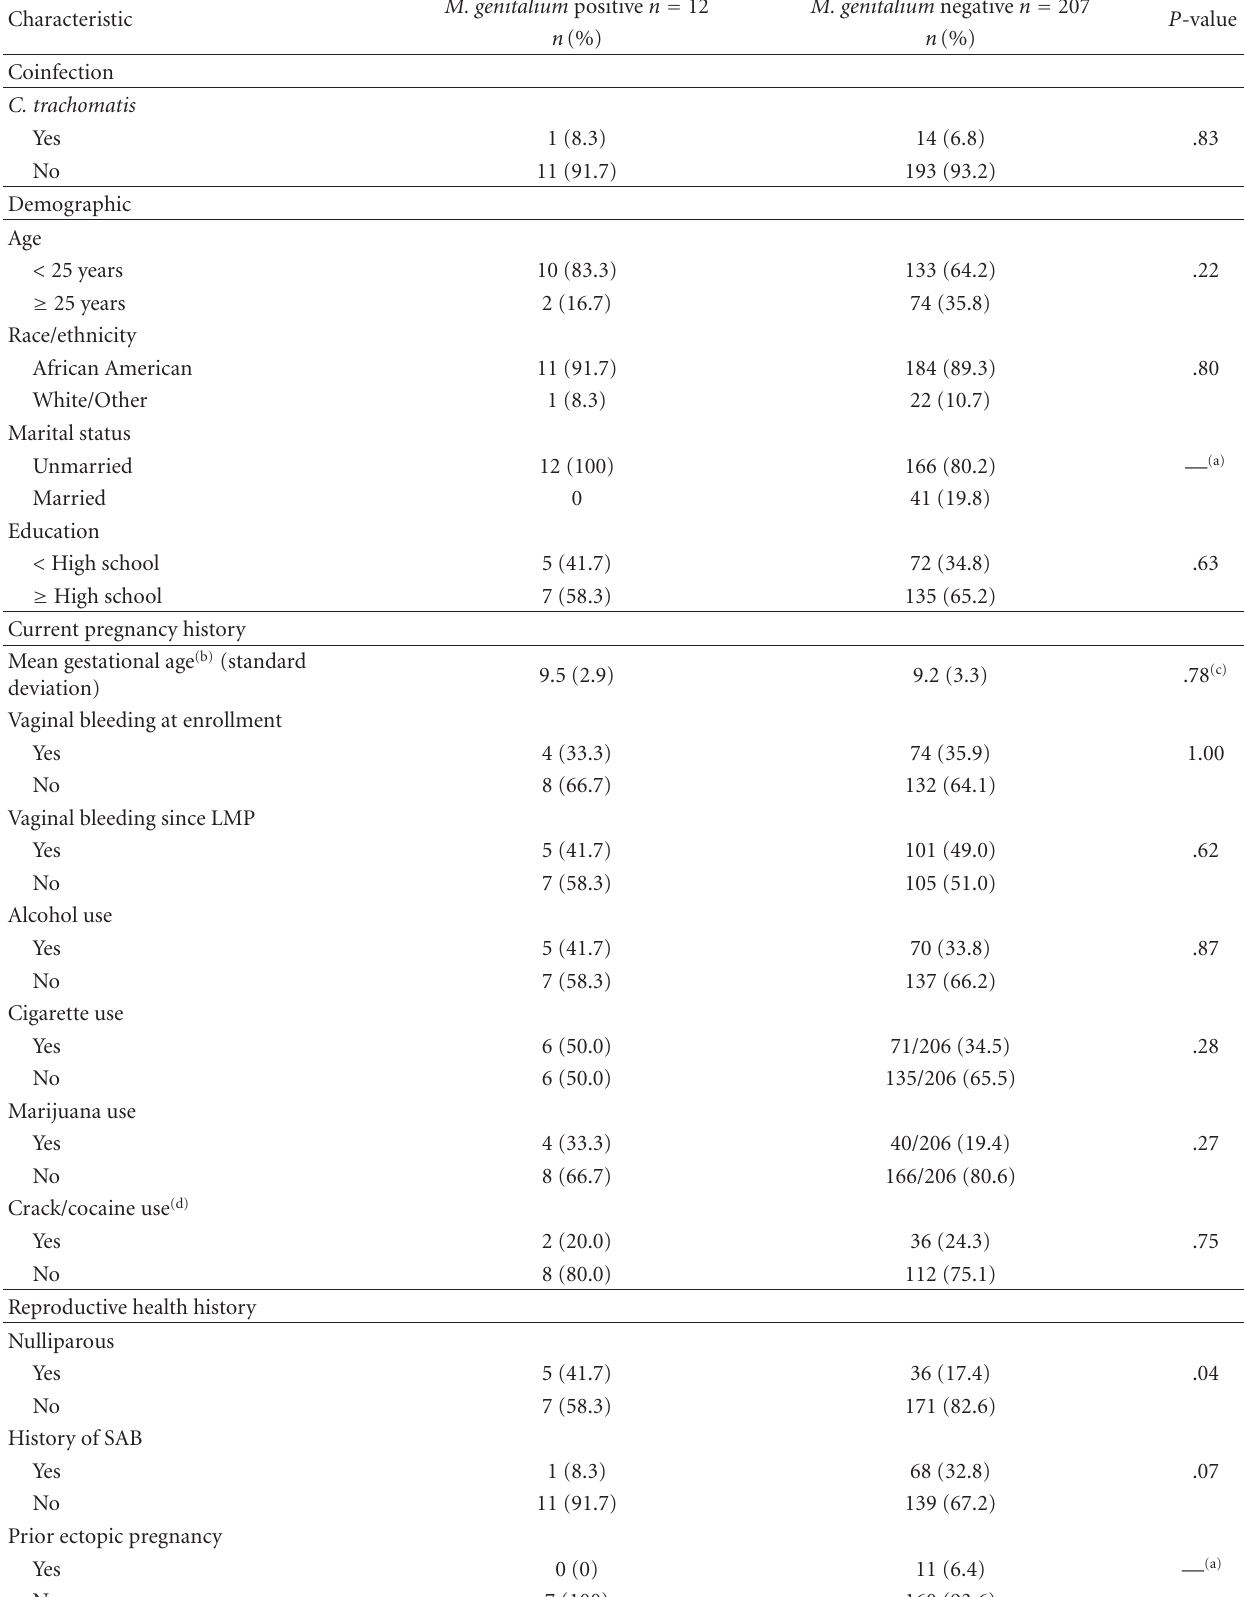
Table 2: Characteristics of study participants according to M. genitalium PCR